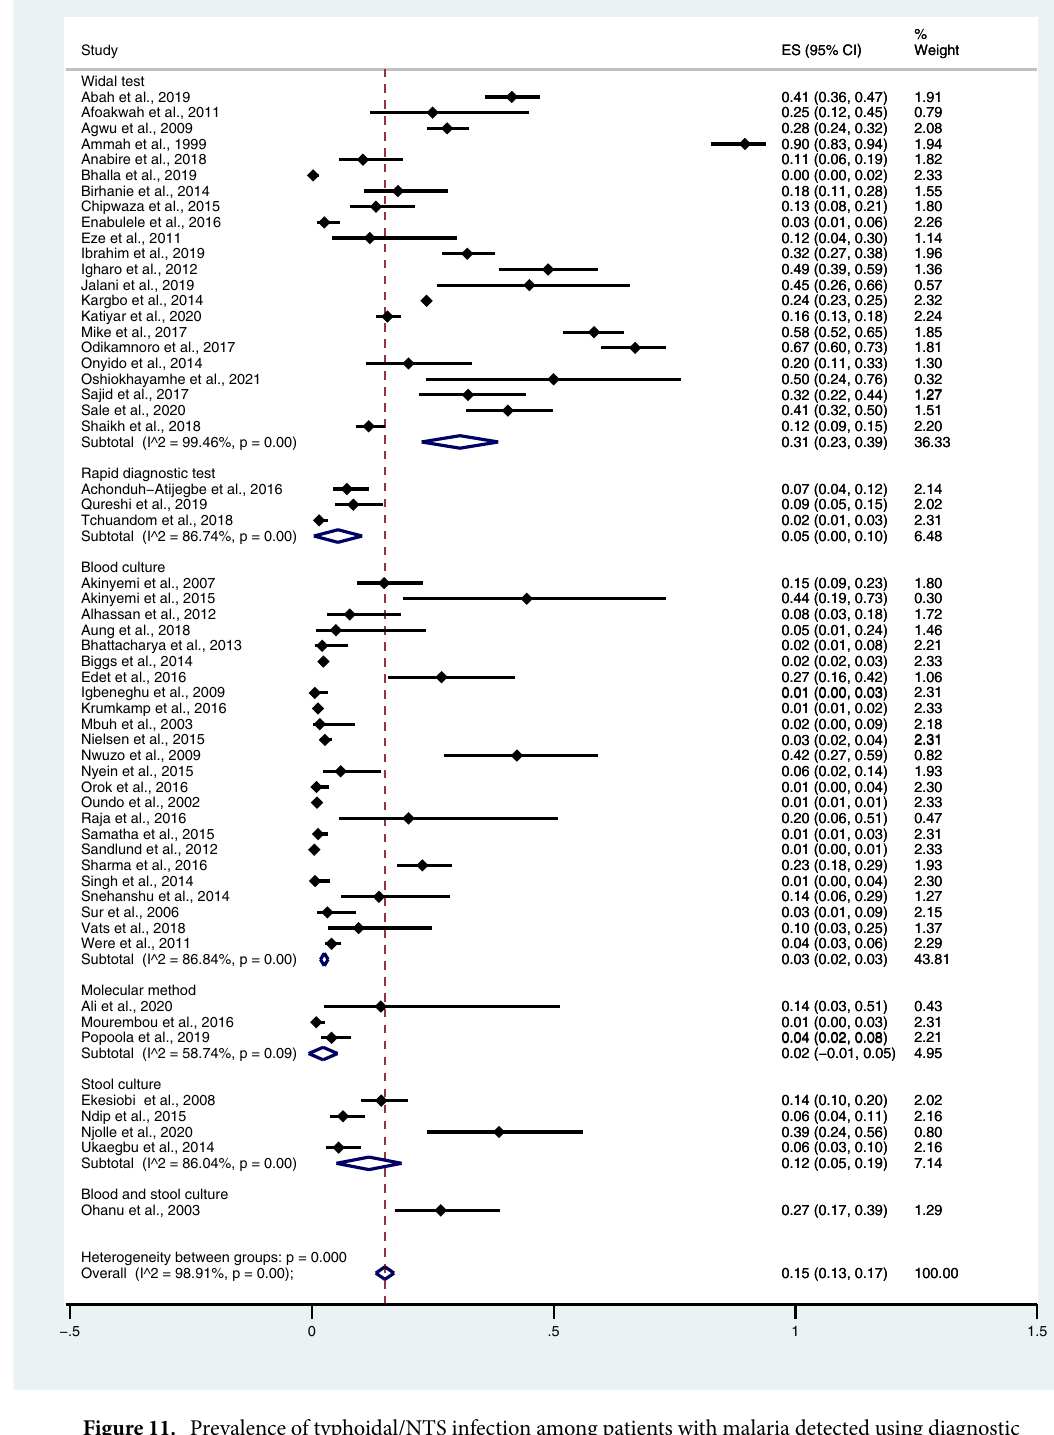
Figure 11. Prevalence of typhoidal/NTS infection among patients with malaria detected using diagnostic tests for Salmonella spp. ES proportion estimate (multiply 100 units for interpreted as prevalence estimate), CI confidence